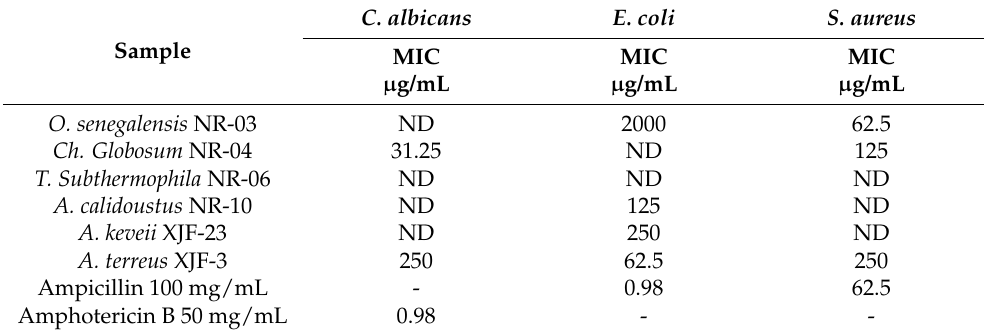
Table 3. Determination of minimum inhibitory (MIC) concentration of endophytic fungi associated with medicinal plant V. anthelmintica